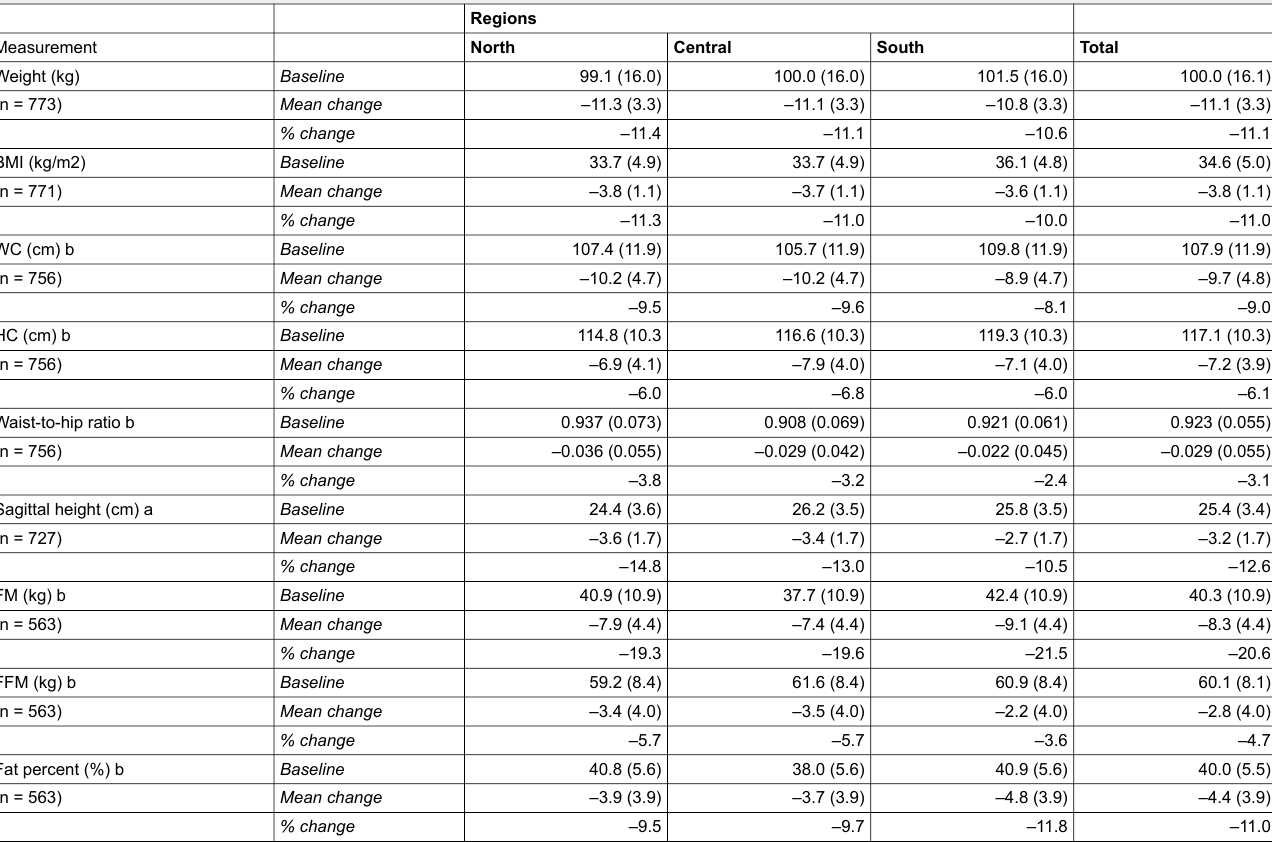
Table 2: Mean (SD) and percental changes in anthropometric and body composition measures over the LCD period in the DiOGenes participating regions ( n 773), 2006–2007.